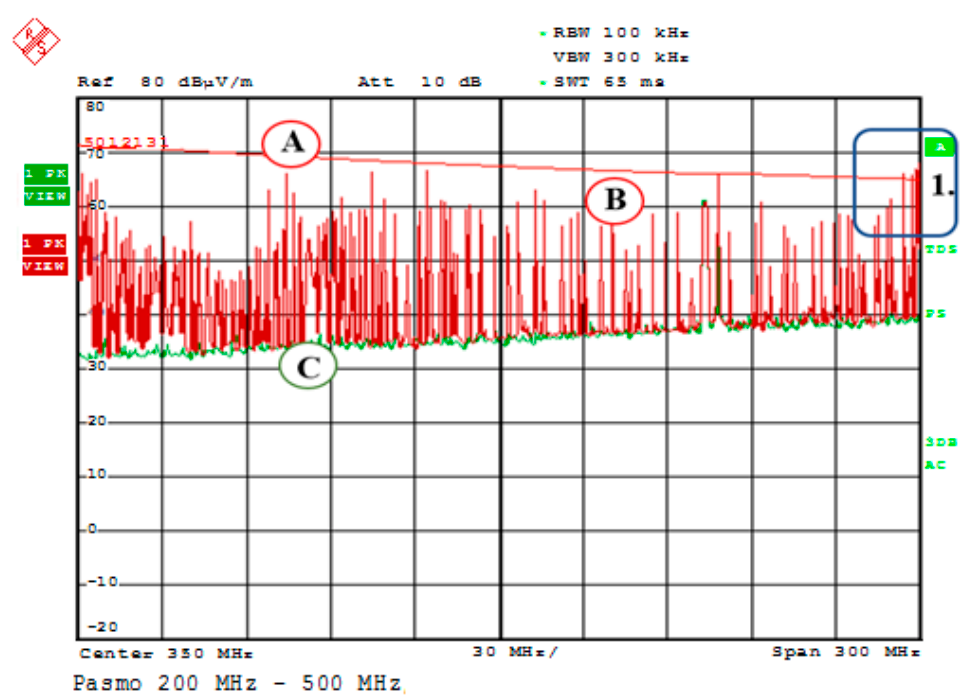
Figure 13. Spectrum of interfering signals radiated by a rail vehicle travelling at a speed of 50 km/h and the electromagnetic background for a frequency range of 200 MHz–500 MHz.